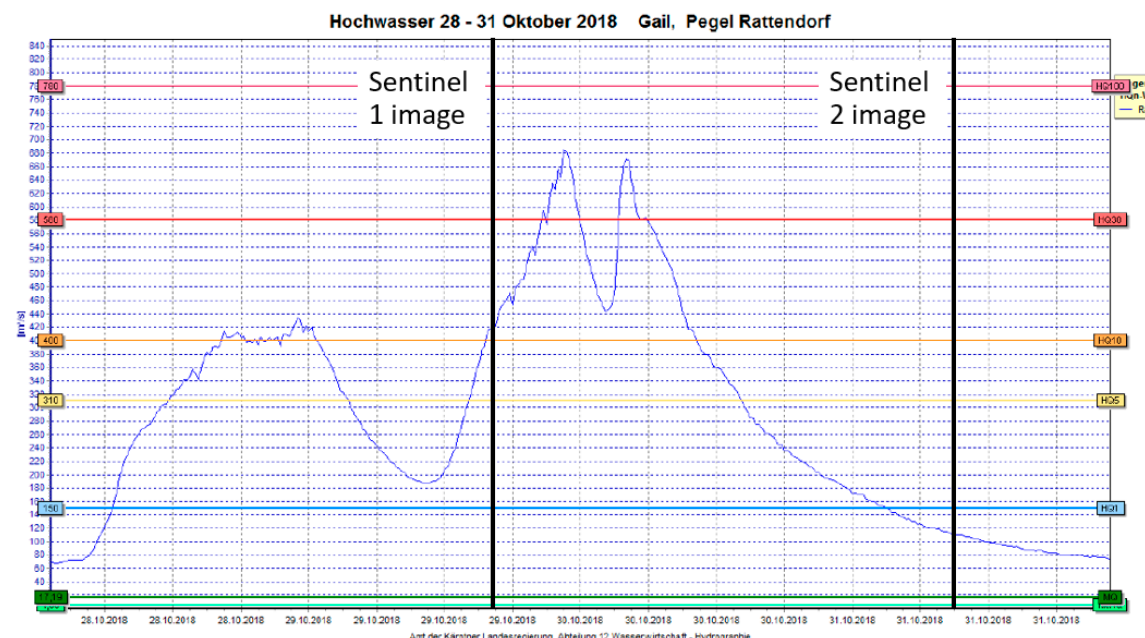
Table 2. Statistical evaluation of comparison between flood extent detected by developed solution and digitized from Sentinel-2 imagery for the Austria, 2018 flood event.